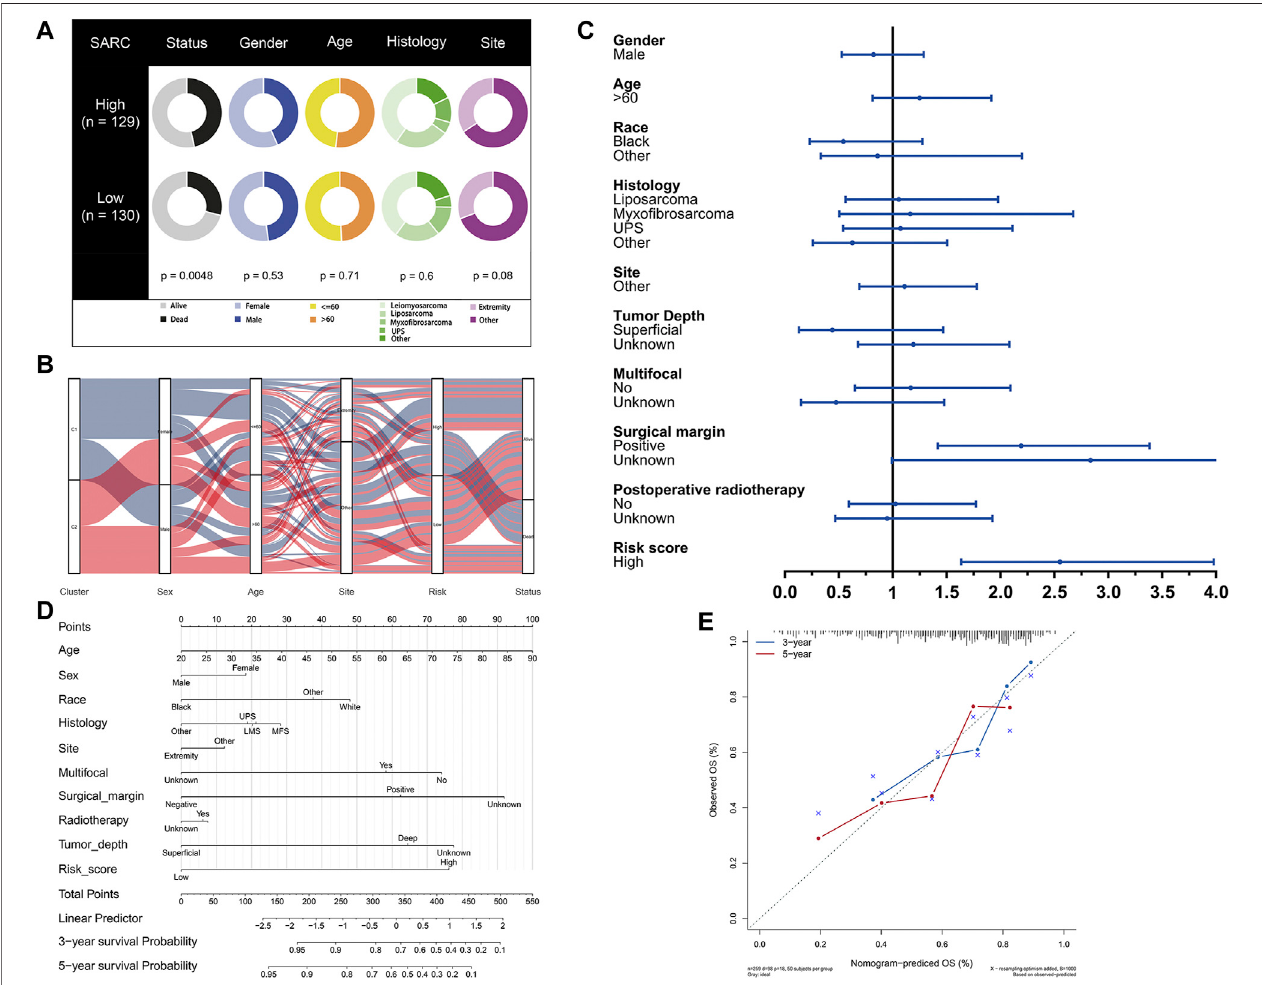
FIGURE 6 | Development of pyroptosis-based prognostic model. (A) Clinical characteristic between low-risk and high-risk groups. (B) Alluvial diagram illustrating the relationship of pyroptosis-based cluster distribution, clinical characteristics, different risk groups and survival outcomes. (C) Multivariate COX regression analysis of clinical characteristics and pyroptosis-based risk score. (D) Nomogram predicting 3-years and 5-years survival rate of STS patients. (E) Calibration curve for predicting OS rate of STS